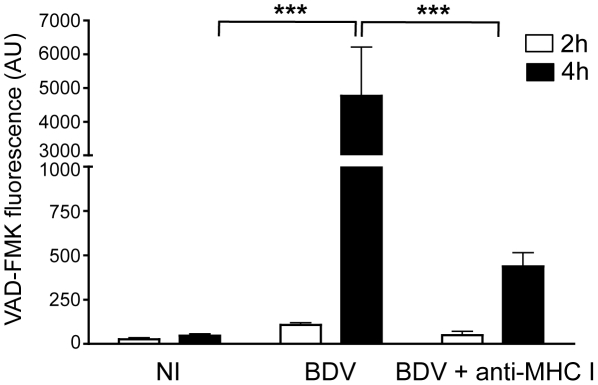
Quantitative analysis of neuronal apoptosis following incubation with brain CD8 T cells.Apoptosis was measured using the fluorescent probe FLICA, and levels of VAD-FMK fluorescence were determined on 5 randomly selected fields for each condition. This analysis was performed upon incubation for 2 hours (white bars) or 4 hours (black bars) with brain purified CD8 T cells (at a ratio of 1∶1) using non-infected neurons (NI), BDV-infected neurons, or BDV-infected neurons treated with a blocking MHC I monoclonal antibody 1 h prior to washes and addition of CD8 T cells. Values are expressed as means ± sem from 5 separate experiments. ***, p<0.001 by Mann-Whitney U-test.